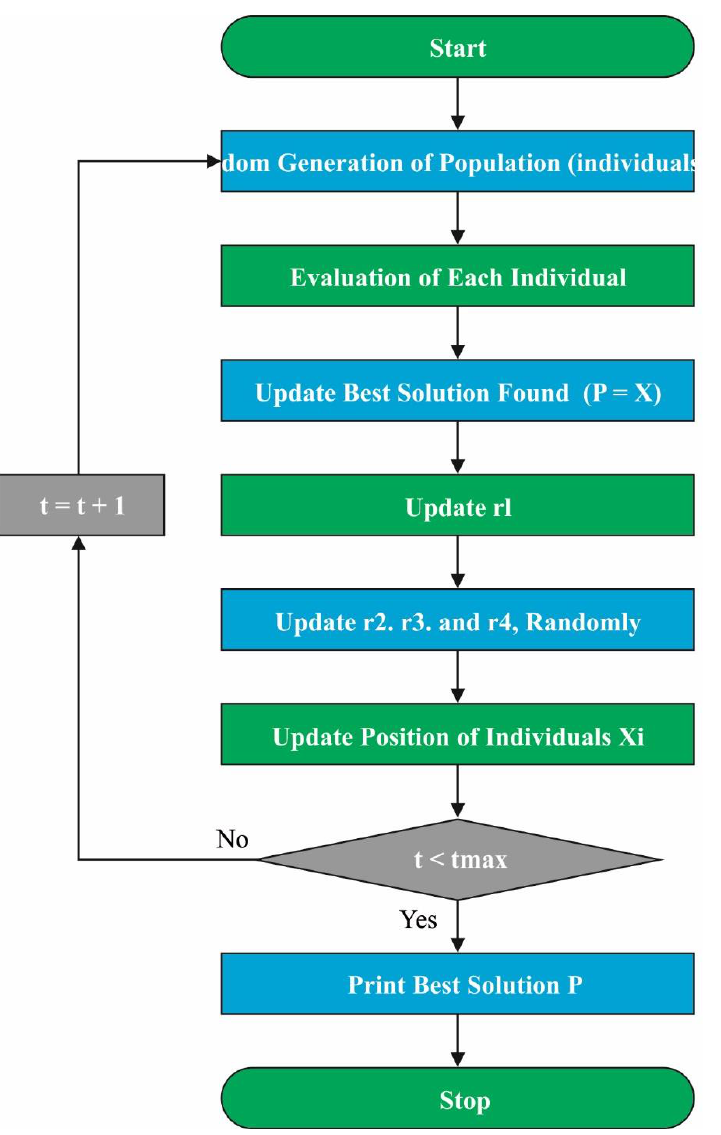
Figure 2. Flowchart of SCA.